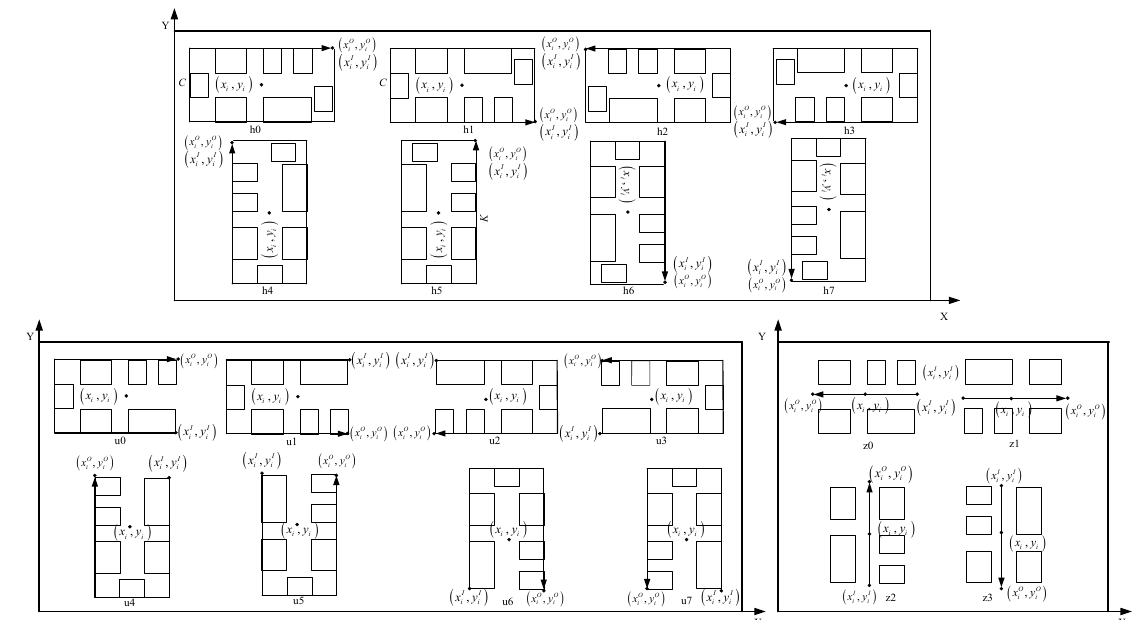
Figure 6. Layout directions of different shapes.